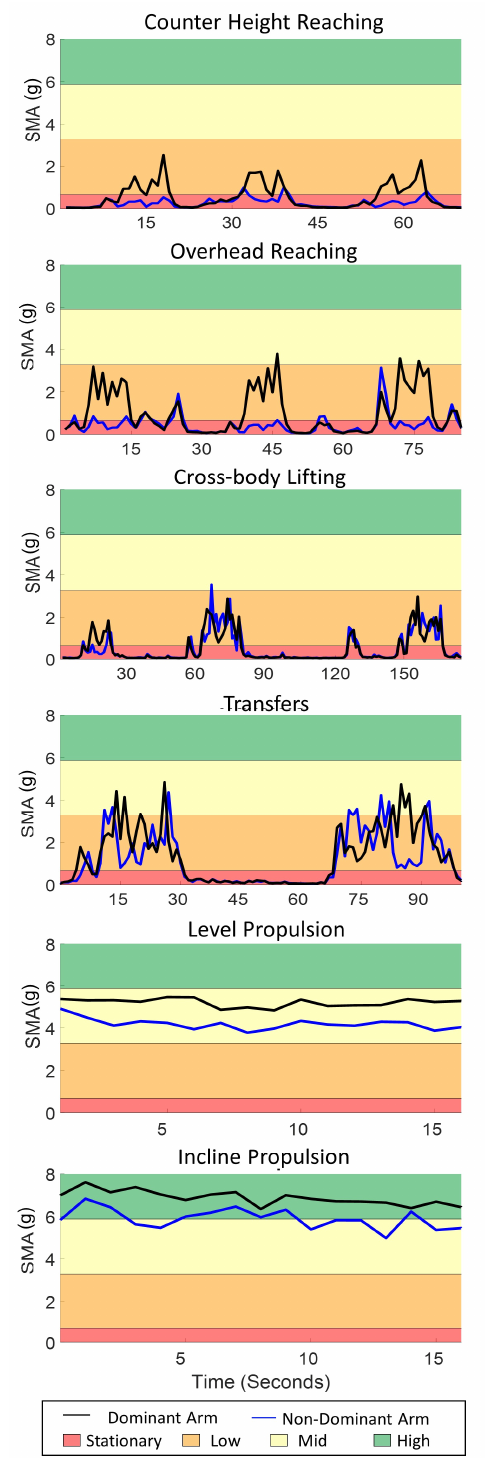
Figure 3. Representative signal magnitude area (SMA) data from one participant completing three counter height reaches, three overhead reaches, three cross body lifts, two transfers, level propulsion and incline propulsion in a structured lab setting for their dominant (black line) and non-dominant (blue line). The shaded areas represent the am use intensity levels (red: stationary, orange: low, yellow: mid, green: